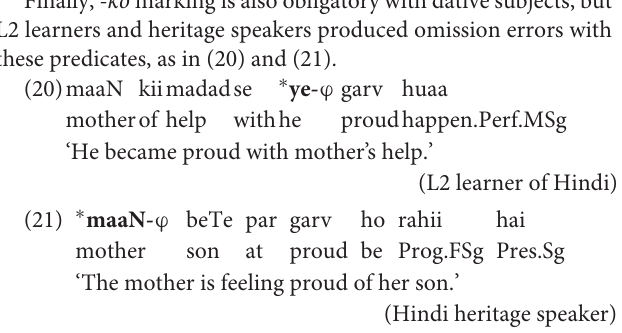
shows the percentage production of - ko marking by NP type (direct objects, indirect objects and dative subjects) and Table 6 shows production of - ko by the animacy of the direct object (Human, non-human animate, and